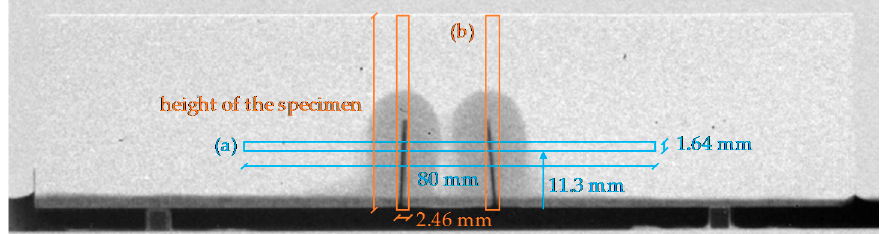
Figure 4. Location and dimensions of the rectangular areas for water profiling in a sample neutron radiography image: ( a ) perpendicular to the cracks; and ( b ) coinciding with the cracks.